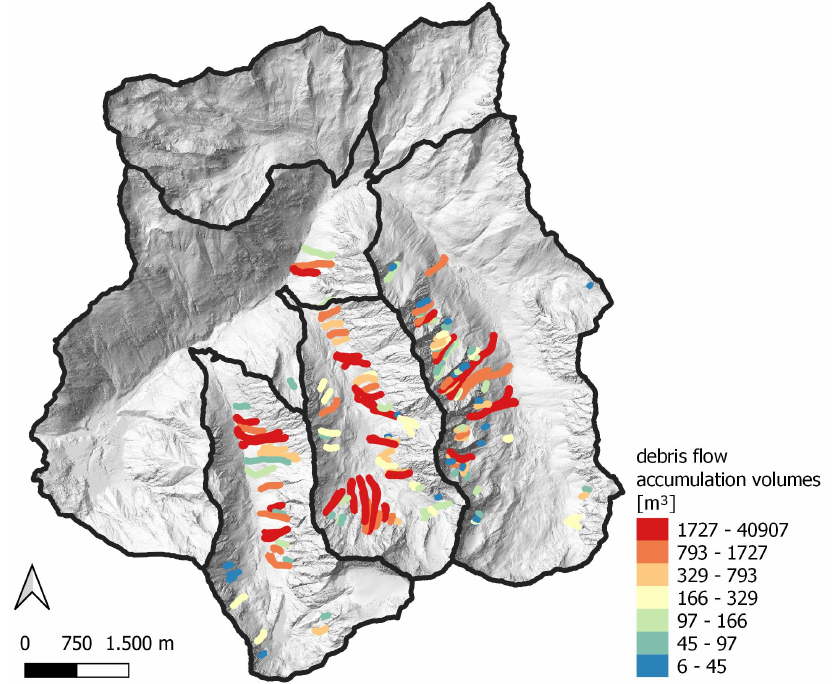
Figure 10. Spatial distribution of the 156 detected debris flows triggered in July 2022, classified by their accumulation